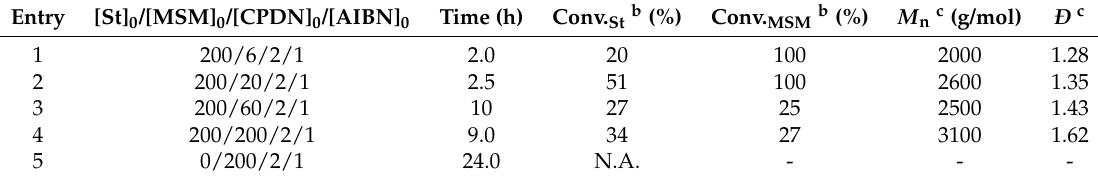
Reversible addition-fragmentation chain transfer (RAFT) polymerization of St and monoselenomaleimide (MSM) under different molar ratios a